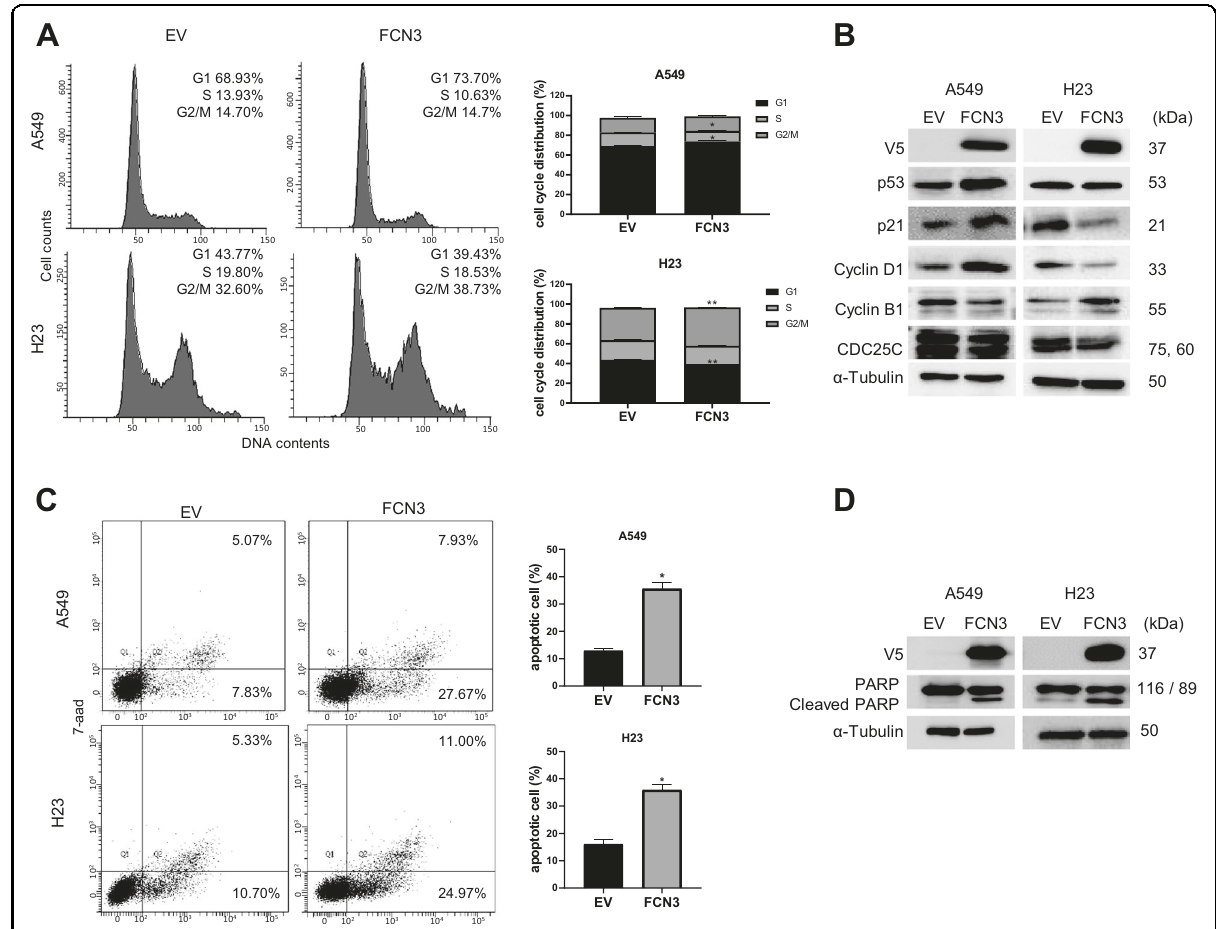
Fig. 3 Ectopic expression of FCN3 induces cell cycle arrests and apoptosis. A A549 and H23 cells were infected with control virus (EV) or FCN3 - expressing virus, and cell cycle progression was analyzed by fl ow cytometry 72 h after infection. Representative histograms are shown, and proportions of cell cycle distribution were presented as bar graphs. G1 arrest was observed in A549 cells, while G2/M arrest occurred in H23 cells. Data are mean ± SEM of three independent experiments. B Immunoblots of various cell cycle markers in A549 and H23 cells 72 h after viral transduction. ɑ – Tubulin was used as the loading control. C A549 and H23 cells were transduced with control virus (EV) or FCN3 -expressing virus, and apoptotic cells were analyzed with fl ow cytometry 96 h after infection. Proportions of apoptotic cells are presented as bar graph. The percentage of apoptotic cells is increased with FCN3 over-expressed cells compared to that in control. Data summarized in the graph are mean ± SEM of three independent experiments. D Immunoblots showing PARP in A549 and H23 cells after 72 h of viral infection. Cleaved PARP is increased in FCN3 -expressing cells. (*) and (**) represent P -values of <0.05 and <0.01 from t tests,